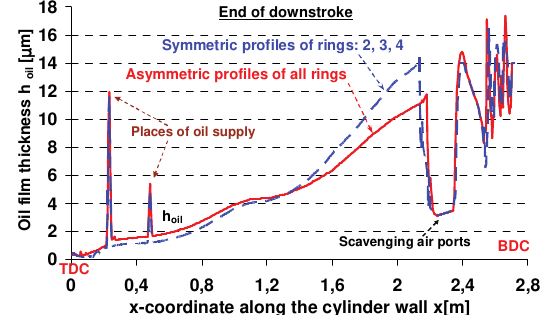
Fig. 9. Comparison of the minimum oil film thickness h min [ m m] of the 1 st (top) piston ring in case of its offset O ff = 5 mm and O ff = 15 mm